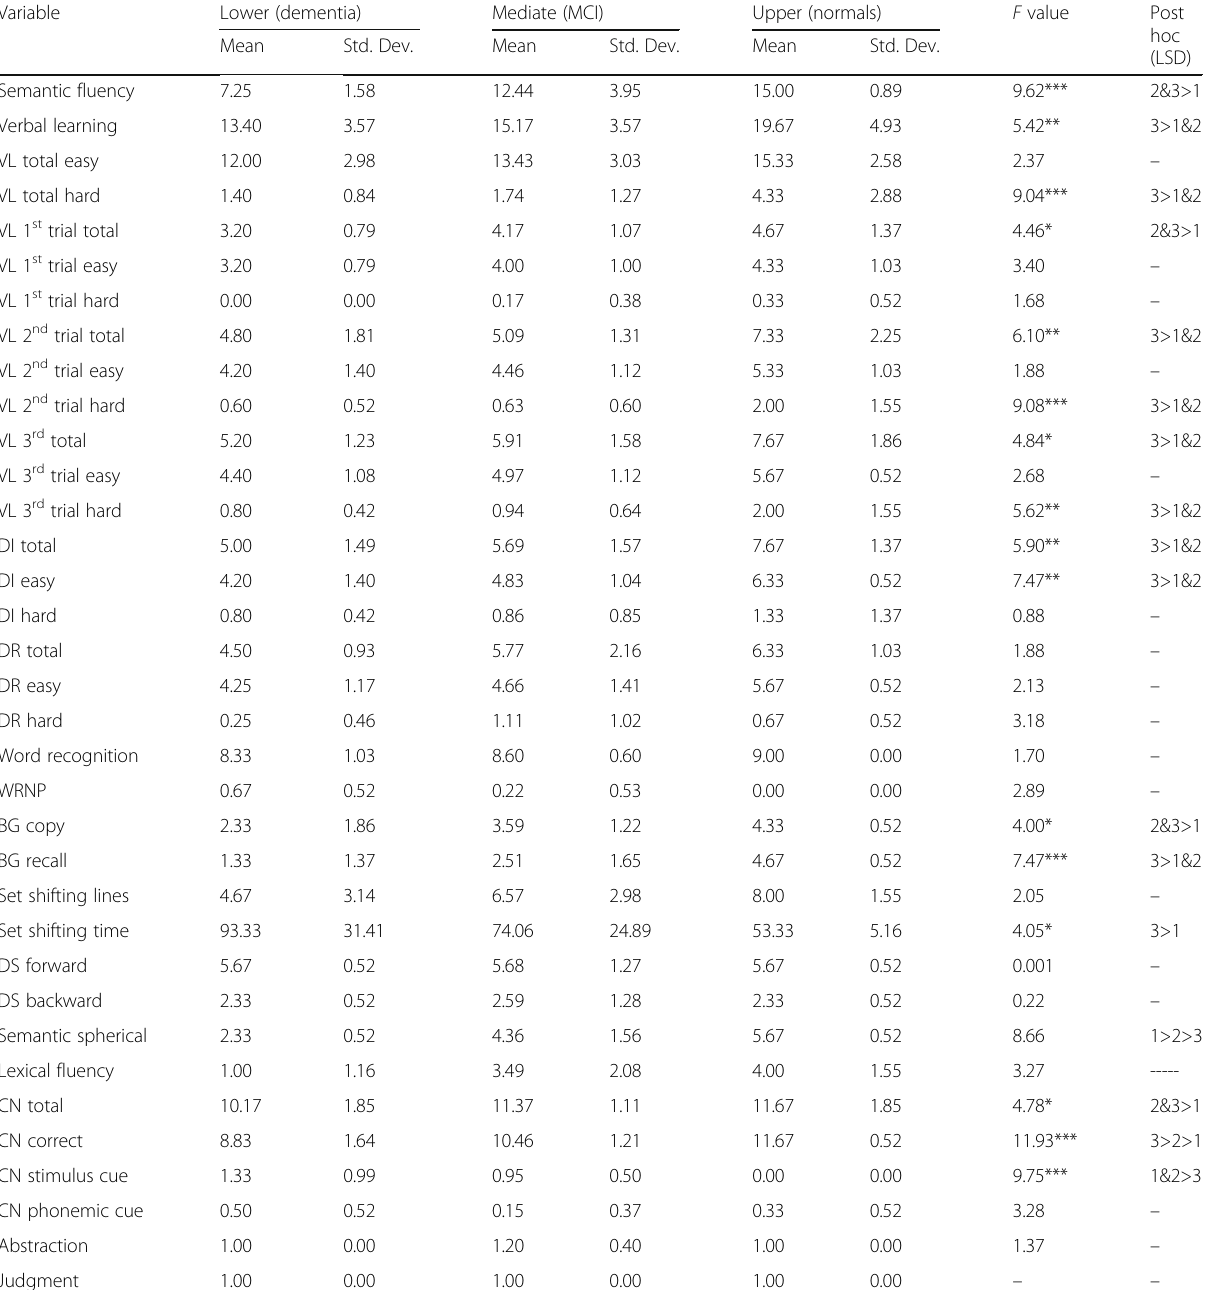
Table 3 Significant F test for between groups accordingly to three quadrants of MMSE within illiterates and low educated ( N = 64) Variable Lower (dementia) Mediate (MCI) Upper (normals) F